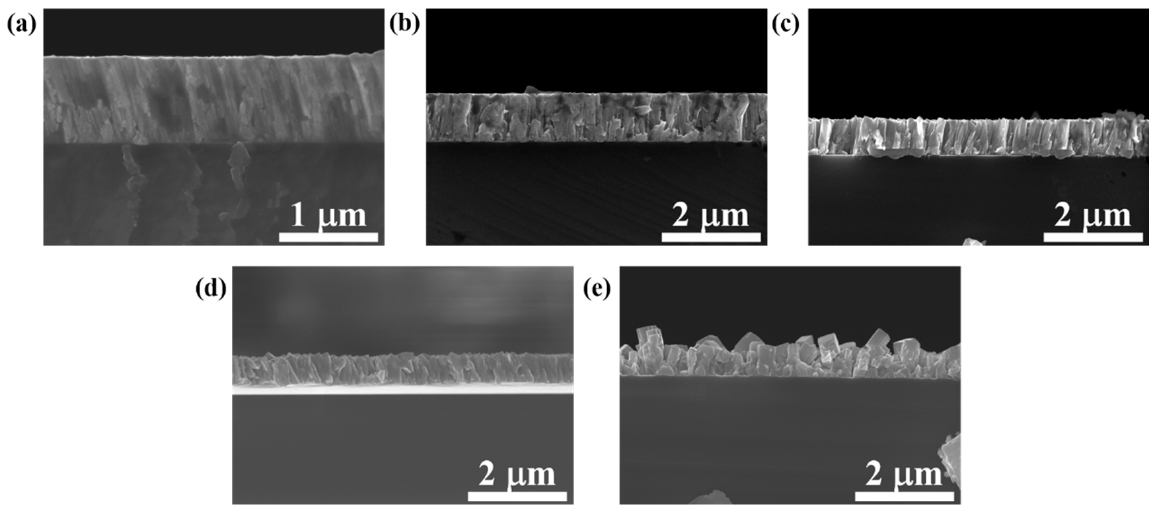
Figure 7. Cross-sectional morphologies of FeCo thin films with thickness of 800 nm deposited at ( a ) 25 °C, ( b ) 200 °C, ( c ) 400 °C, ( d ) 475 °C and ( e ) 550 °C.